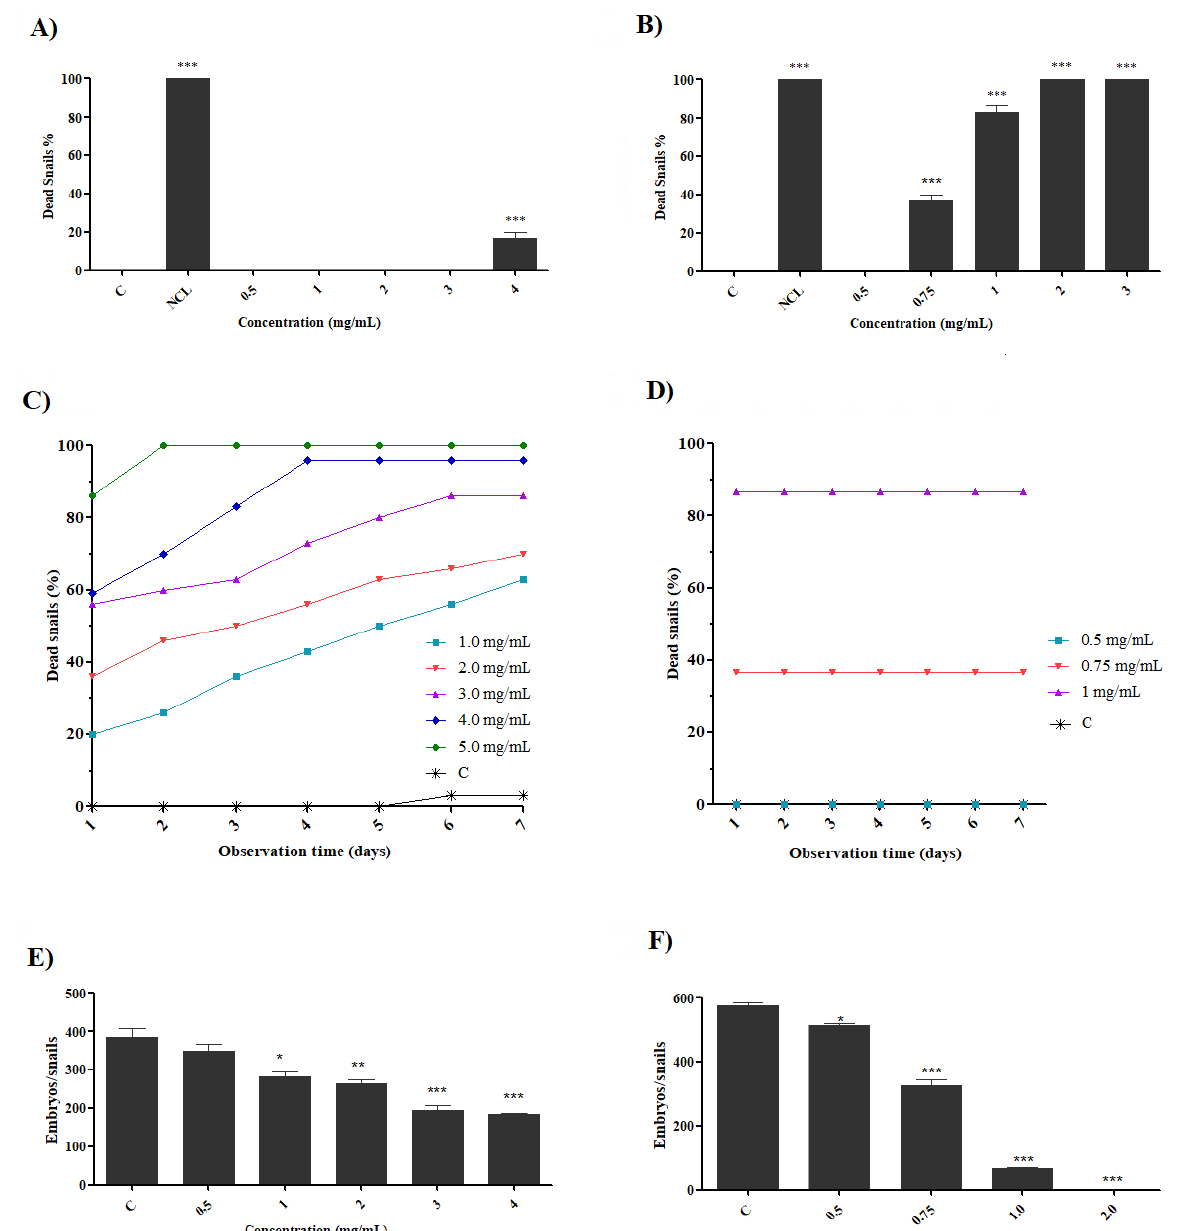
Figure 4. Molluscicidal activity against adult B. glabrata snails. Snails exposed to saline extract ( A ) and fraction for 24 h ( B ); snails exposed to saline extract ( C ) and fraction after 7 days of observation ( D ); fecundity of snails exposed to saline extract ( E ) and fraction after 7 days of observation ( F ). C = negative control; NCL = niclosamide: 1.0 µ g/mL. Each concentration was compared with the negative control: significance * = p < 0.05; ** = p < 0.01 and *** = p <